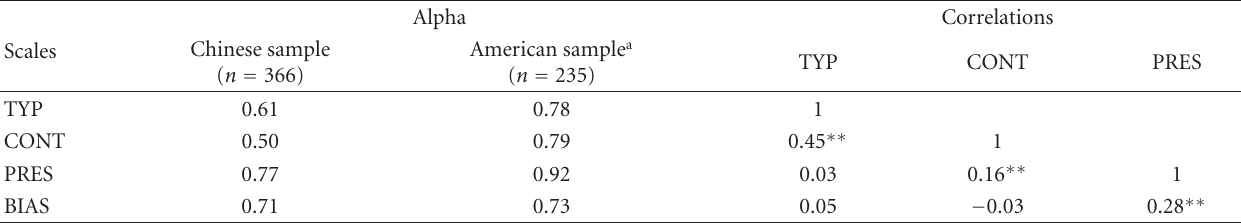
Table 1: Internal consistency reliability of the four-scale gender identity measure for the current Chinese sample and zero-order correlations among scales.